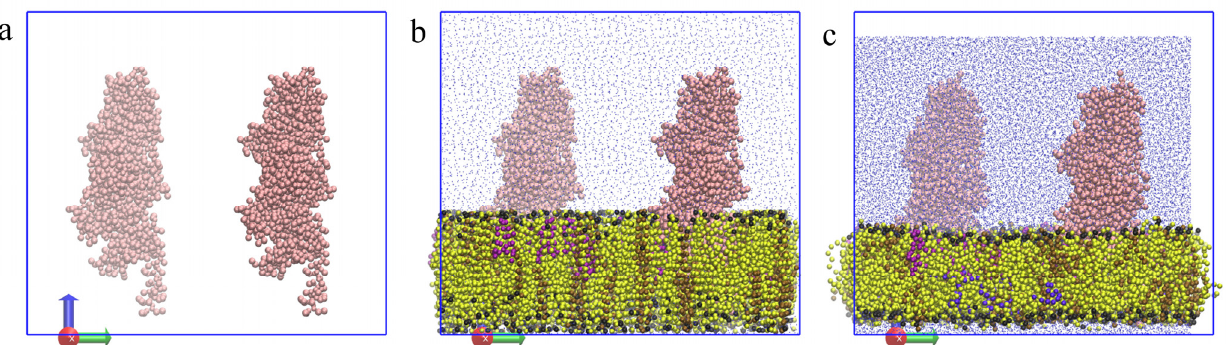
Figure 6. Illustration the different steps of the system preparation as described in Methods section. Phosphate group of the lipids are represented in black, 1,2-dioleoyl-sn-glycero-3- phosphoethanolamine (DOPE) molecules in yellow, 1,2-dioleoyl-sn-glycero-3- phosphoglycerol (DOPG) in brown, toy lipids in purple, water in blue and proteins in pink. ( a ) The proteins are inserted in the box; ( b ) The preorganized lipids were added in the correct space before solvation; ( c ) The system after 2.5 ns of simulation.